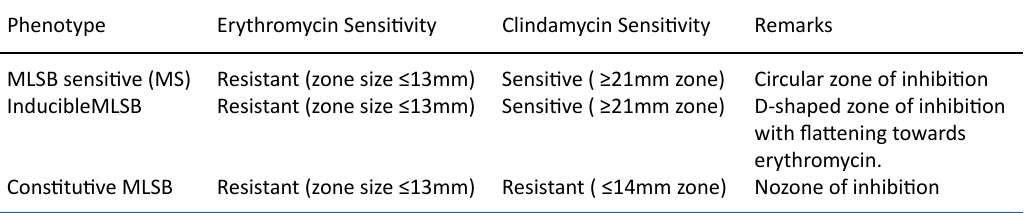
Table 1. Phenotypes of strains towards MLSB antibiotics